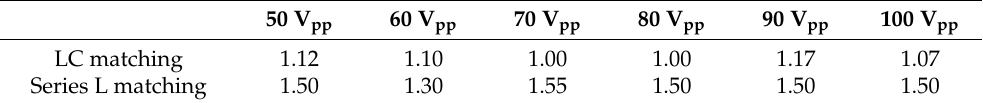
Table 3. Voltage gains depending on matching conditions.